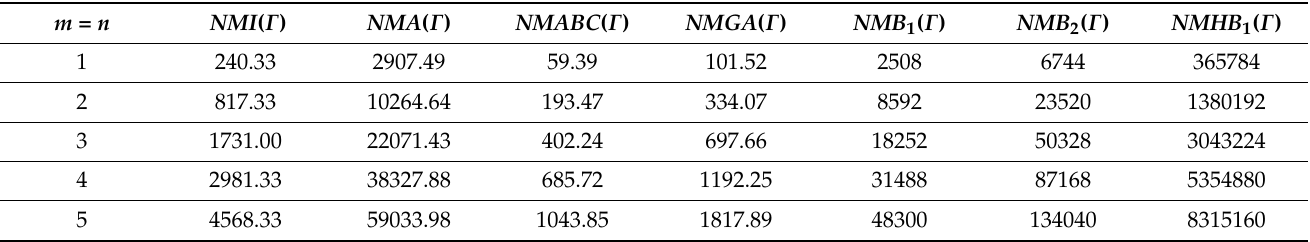
Table 14. Comparison Table for Theorem 8.